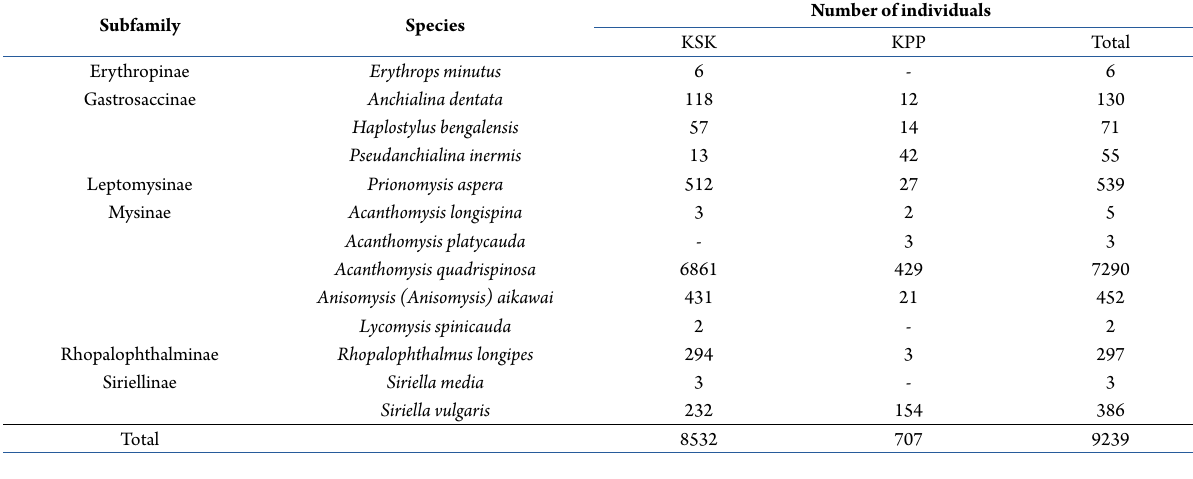
Number of individuals